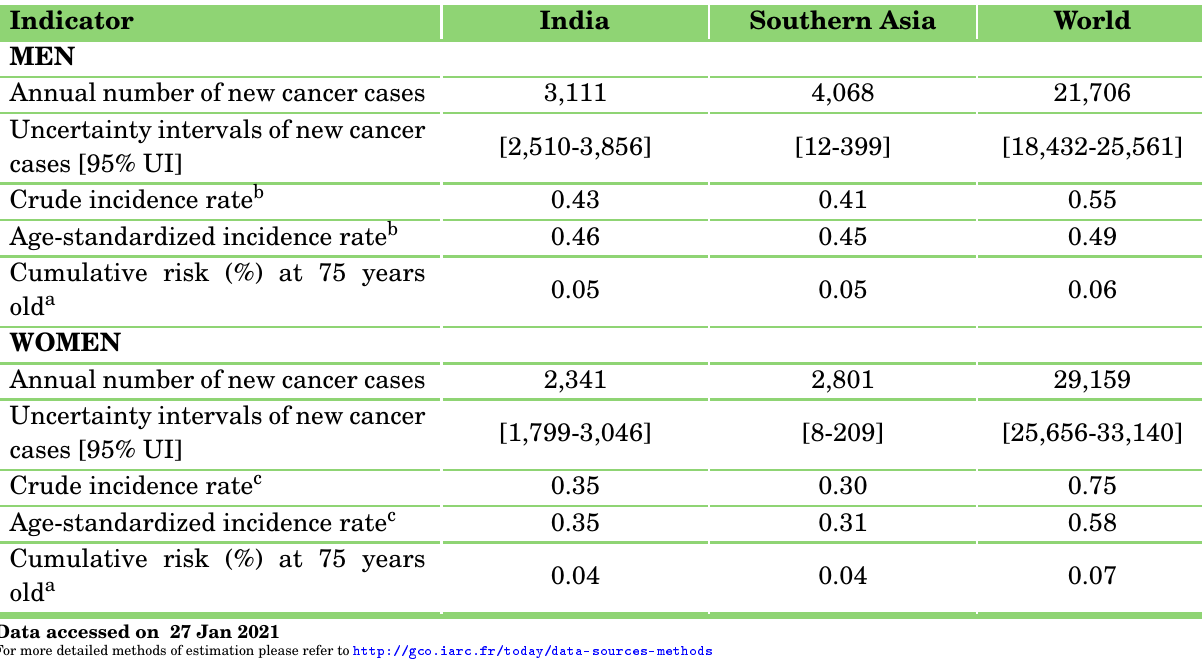
Table 7: Anal cancer incidence in India (estimates for